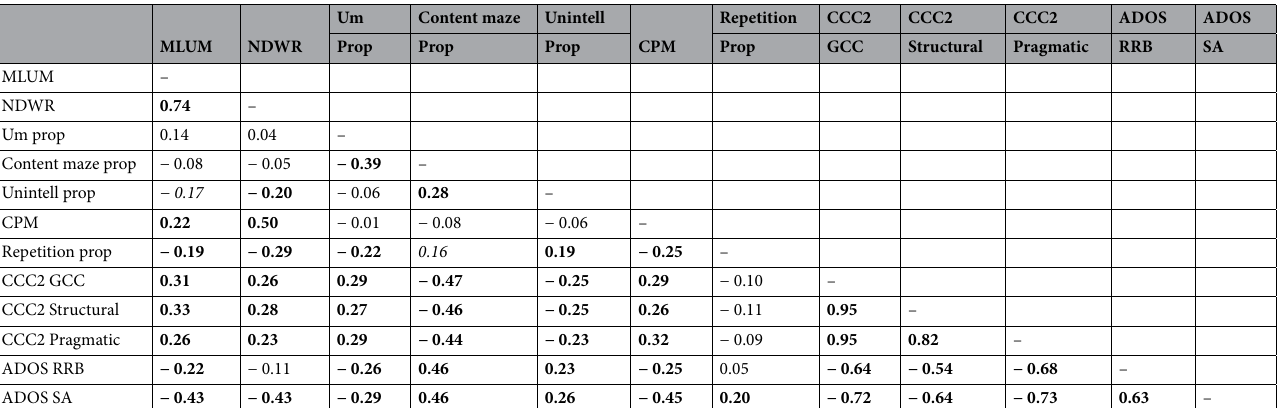
Table 4. Relationship of ALMs to clinical scores using Spearman correlations. Italics indicates significance with .01 < p < .05 . Boldface indicates significance with p < .01 .